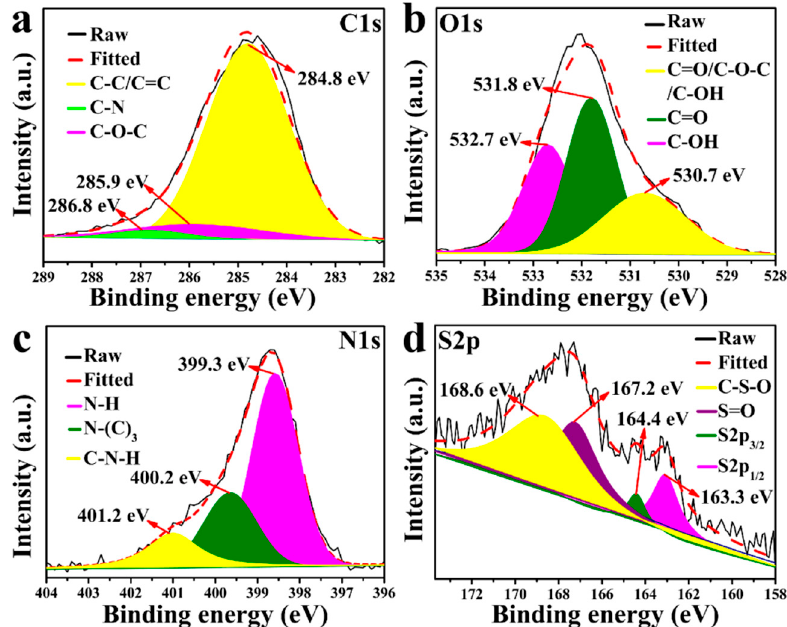
Figure 2 . ( a ) High − resolution C1s XPS spectrum of CDs; ( b ) high-resolution O1s XPS spectrum of CDs; ( c ) high − resolution N1s XPS spectrum of CDs; ( d ) high-resolution S2p XPS spectrum of